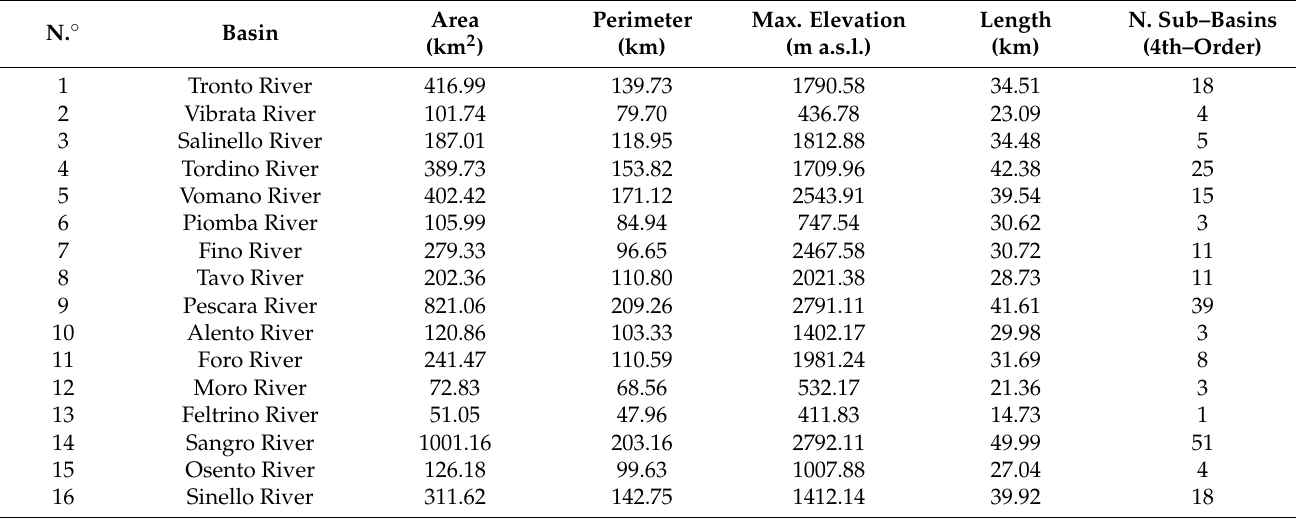
Table 1. Main morphometric parameters of the basins in the study